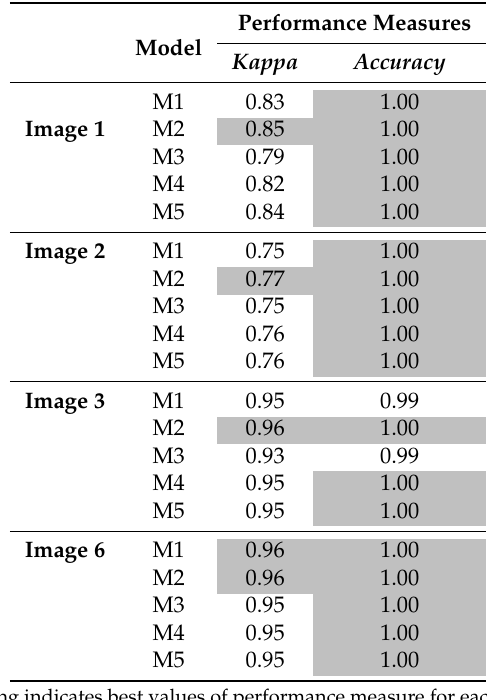
Table A4. Pearson correlation coefficients between performance measures, across all images and models (higher values indicate parameters are strongly correlated).